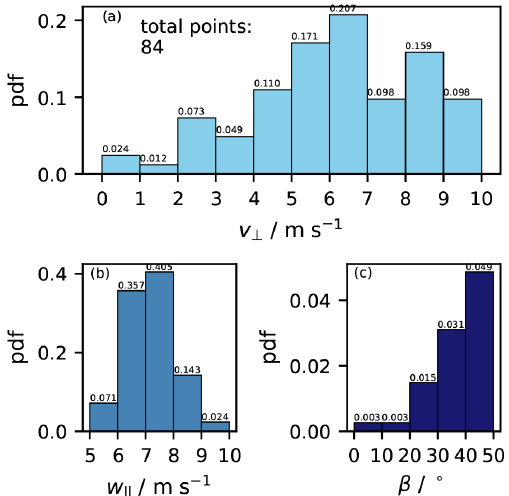
Figure 7. Probability density functions (pdfs) of impact parameters at the top end of the CFH intake tube during the passage through the mixed-phase cloud of flight NT011. (a) Velocity v ⊥ perpendicular to the tube walls; (b) velocity w || parallel to the axis of the tube; (c) impact angle ( β